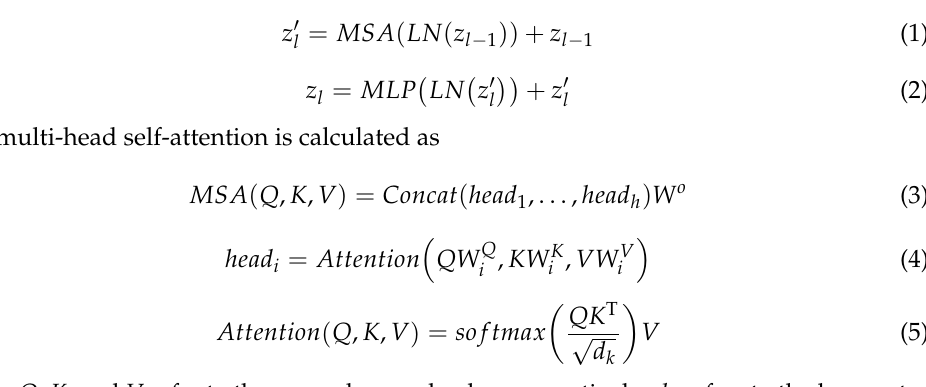
Figure 3. Transformer block.